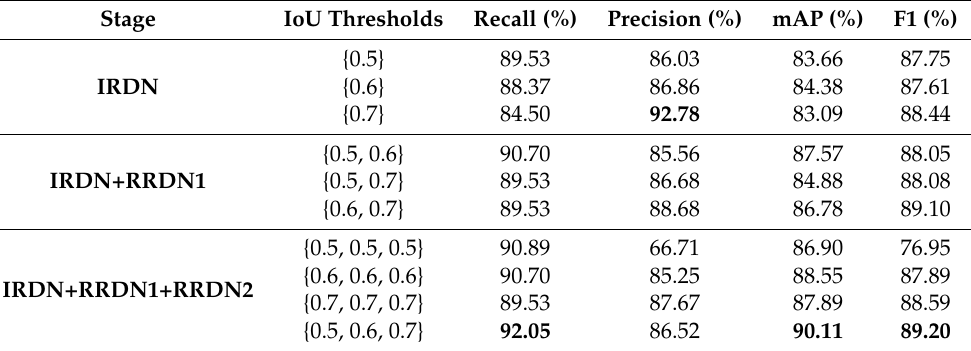
Table 2. Experimental results of MSRDN.